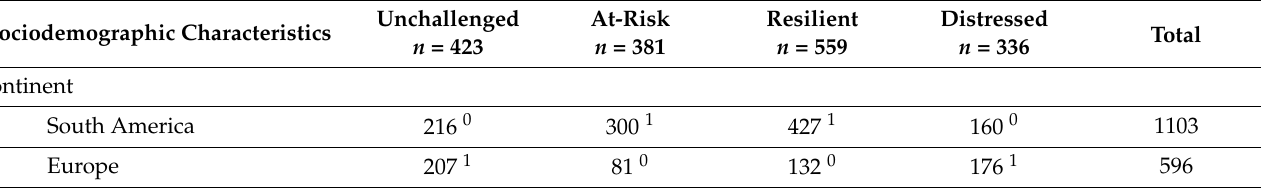
Table 3. Sociodemographic Characteristics Across Each Psychological Adjustment